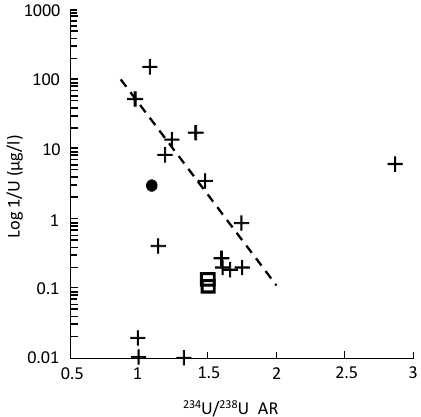
Figure 4. 234 U/ 238 U AR versus log 1/U concentrations for the spring 1 waters (samples 1), groundwaters (samples 2–18) and lake waters (sample 19) from the Shihongtan U ore district flow system. Data from Table 1. Symbols as in Figure 3.